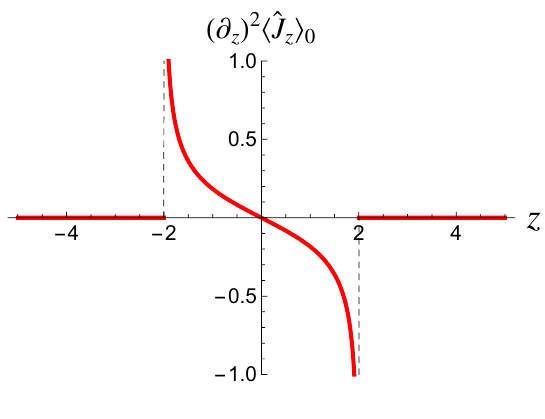
Figure 6 . d 2 h ^ J z i 0 =dz 2 vs. z , for (cid:13) =